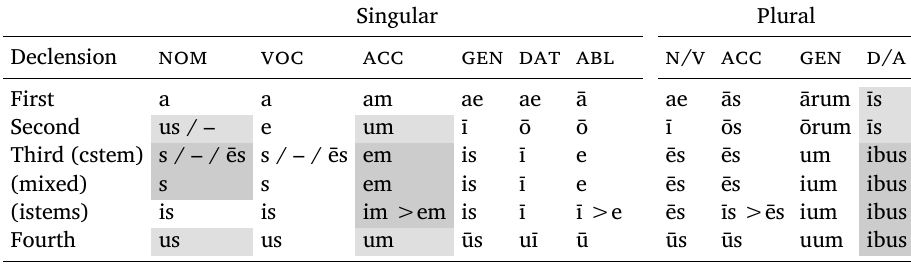
Table 2: Latin masculine declensional endings without and with thematic vowels Singular Plural Declension nom voc acc gen dat abl